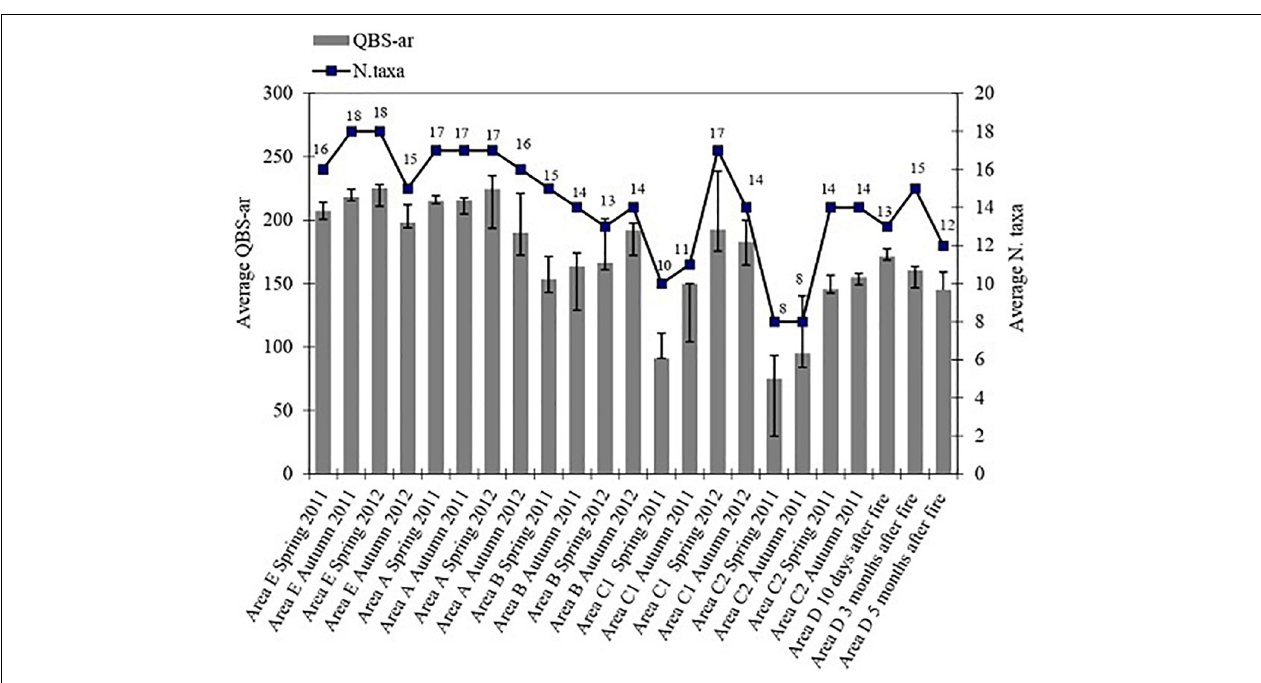
FIGURE 2 | Average number of taxa and average values of QBS-ar in the sampling area from Spring 2011 to Autumn 2012.